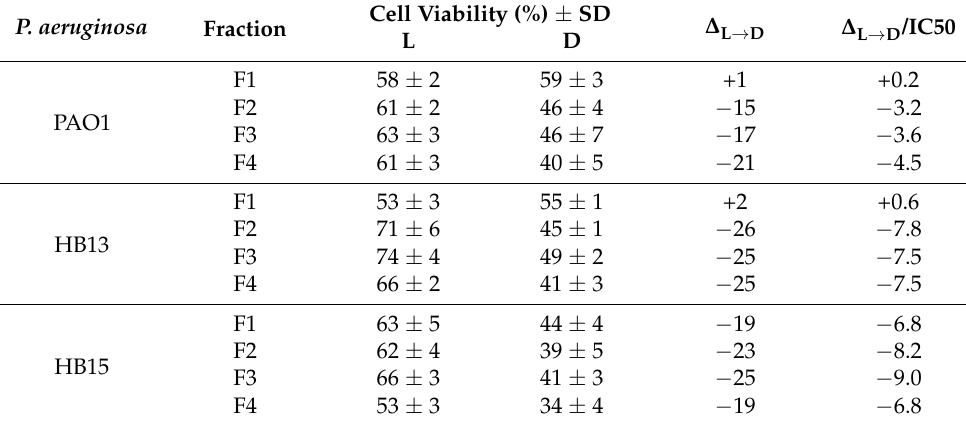
Table 2. Summary of the effective response on the viability of A549 cells (%) induced by fractions of P. aeruginosa grown in constant exposure to full-spectrum light (L) and total absence of light (D). Cells were incubated with a specific concentration (Table 1). Standard deviations are represented ( ± SD). The percentage variation on the effective response on the viability considering a light to dark switch was determined ( ∆ L → D ), also taking in consideration the administrated concentration of each fraction ( ∆ L → D /IC50). P.